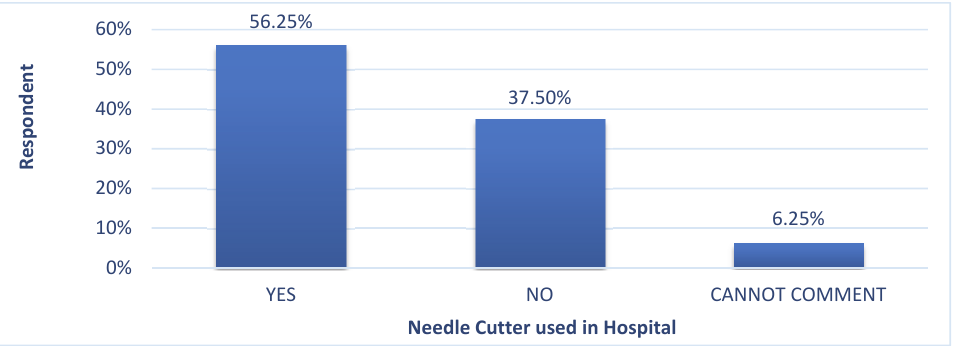
Needle Cutter used in Fig. 4. Use of